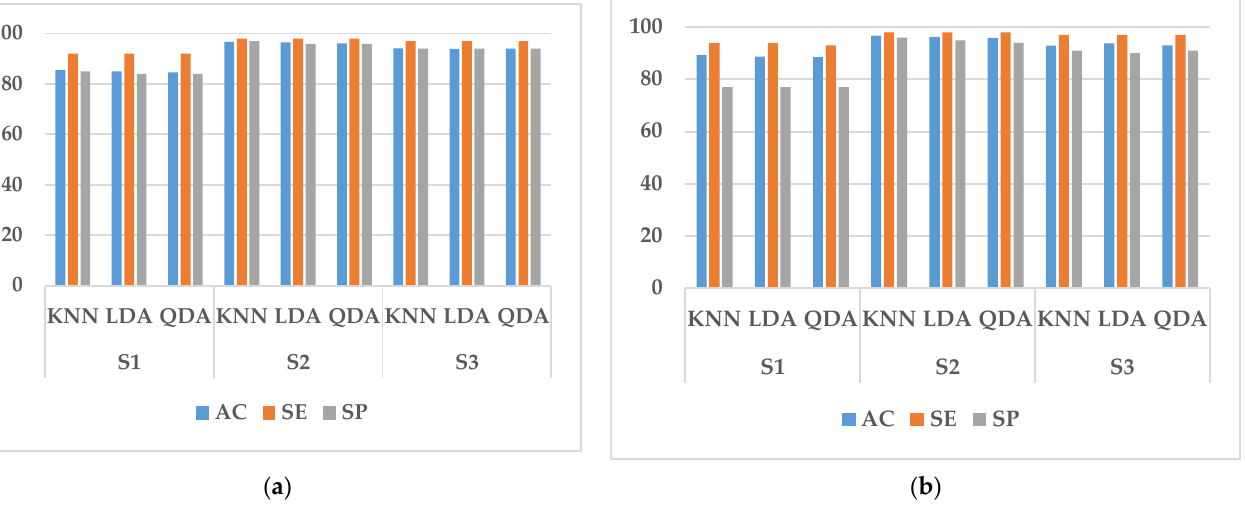
Figure 6. K-fold cross-validation of ECG data. ( a ) Vehicle driving experiment; ( b ) Simulated driving experiment.